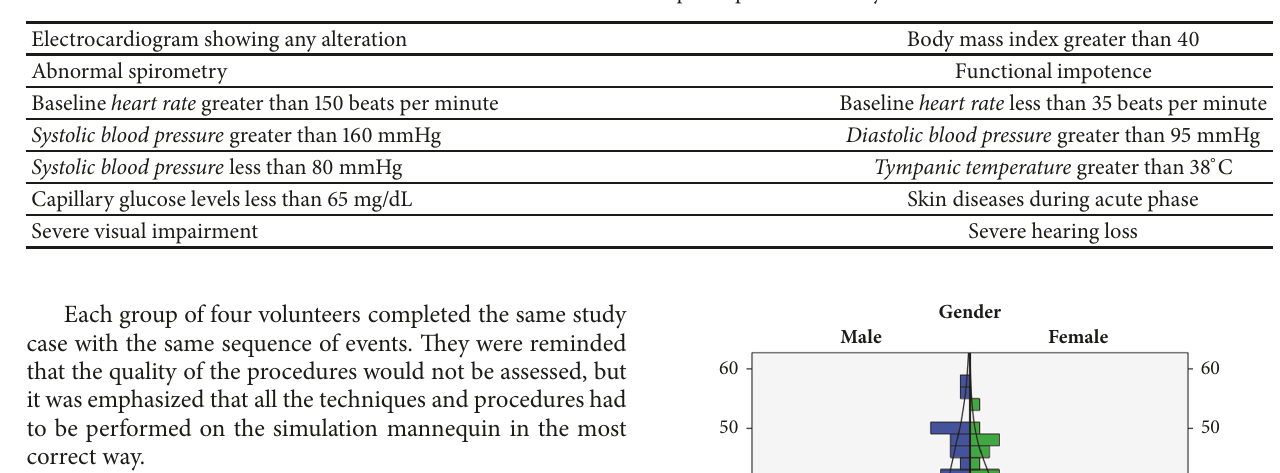
Table 1: Exclusion criteria to participate in the study.